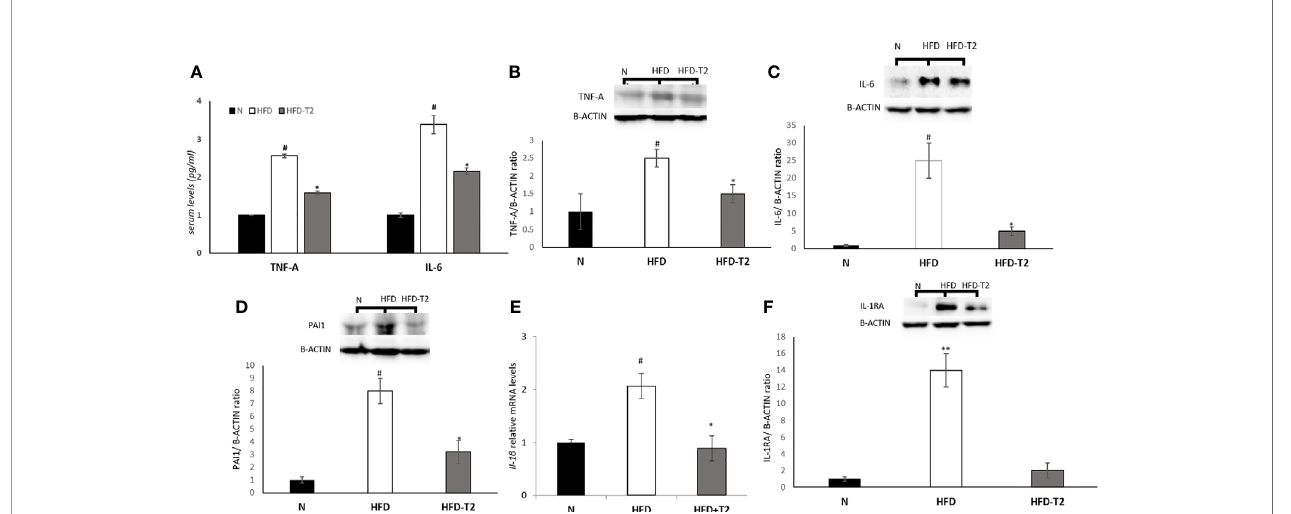
FIGURE 5 | Effects of T2 administration on TNF-A and IL-6 serum levels and on expression of some pro-in fl ammatory cytokines in vWAT. (A) TNF-A and IL-6 were detected by a competitive Enzyme Linked-Immunosorbent Assay (ELISA) in serum of N, HFD, HFD-T2 rats; (B – D, F) Western blot images and densitometry showing relative expression of the main pro-in fl ammatory cytokines in vWAT. (B) Tumor necrosis factor A (TNF-A); (C) Interleukin-6 (IL-6), (D) Plasminogen Activator Inhibitor 1 (PAI1); (F) Interleukin-1 Receptor Antagonist (IL-1RA); B-ACTIN has been used as a loading control. Representative blots are shown; (E) RT-qPCR analysis of IL-1B in vWAT. The histograms represent means ± SEM of fi ve independent experiments (n = 5), *P < 0.05 vs. HFD, # P < 0.05 vs. N, **P < 0,05 vs. N and HFD-T2. N: rats receiving a standard diet for 14 weeks; HFD: rats receiving a HFD for 14 weeks; HFD-T2: rats receiving a HFD for 14 weeks with a daily administration of T2 during the last 4